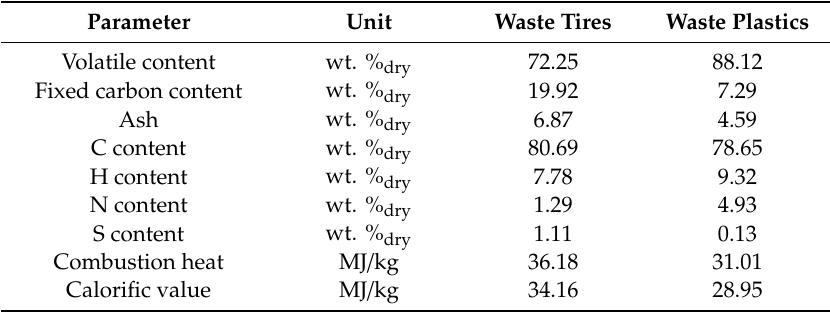
Table 1. Input waste materials